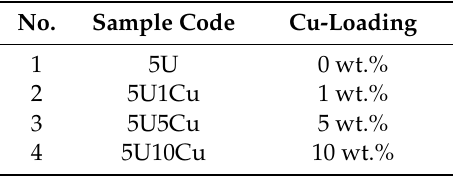
Table 5. List of the analyzed fresh samples and their